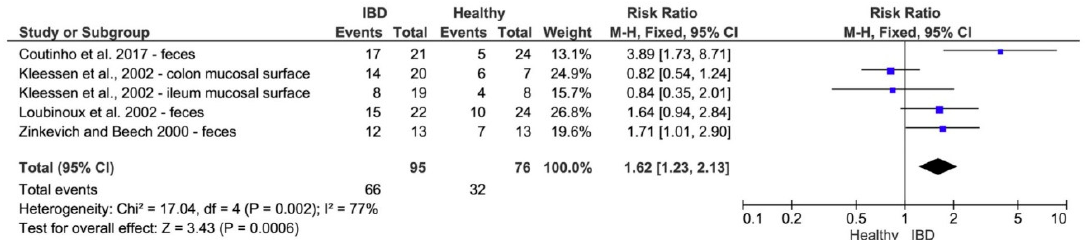
Figure 7. Forest plot showing the relation between the presence of sulfate-reducing bacteria (SRB) and the prevalence of inflammatory bowel diseases (IBD) [21].